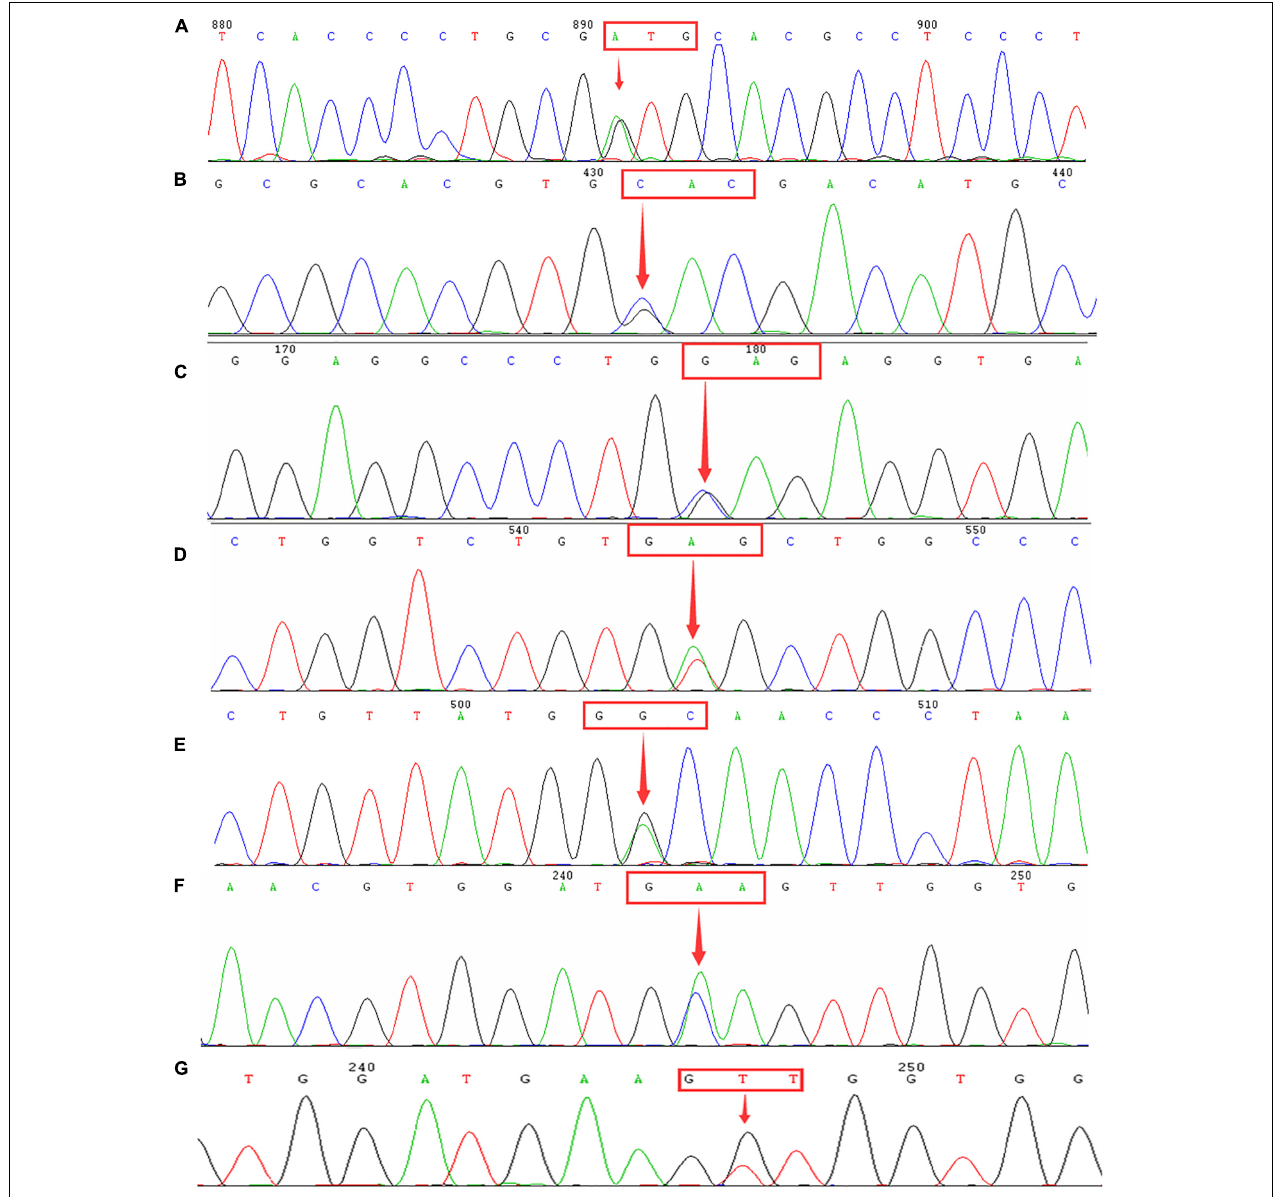
FIGURE 4 | Identification of hemoglobinopathies using DNA sequencing. Arrows indicate the location of the mutations. (A) Hb Owari (GTG > ATG at codon 121) mutation in the HBA1 gene. (B) Hb Q-Thailand (GAC > CAC at codon 74) mutation in the HBA1 gene. (C) Hb G-Honolulu (GAG > CAG at codon 30) mutation in the HBA2 gene. (D) Hb New York (GTG > GAG at codon 113) mutation in the HBB gene. (E) Hb J-Bangkok (GGC > GAC at codon 56) mutation in the HBB gene. (F) Hb G-Coushatta (GAA > GCA at codon 22) in the HBB gene. (G) Hb Miyashiro (GTT > GGT at codon 23) mutation in the HBB